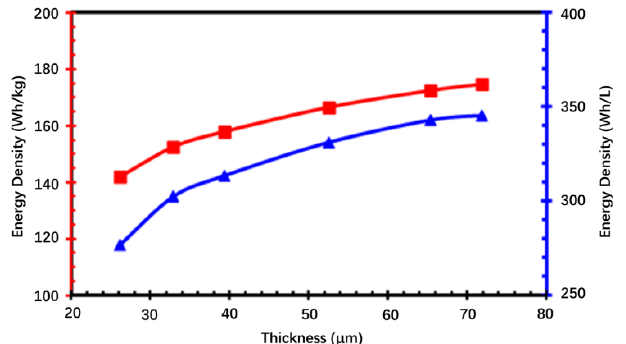
Figure 4. Relationship between electrode thickness and energy density.